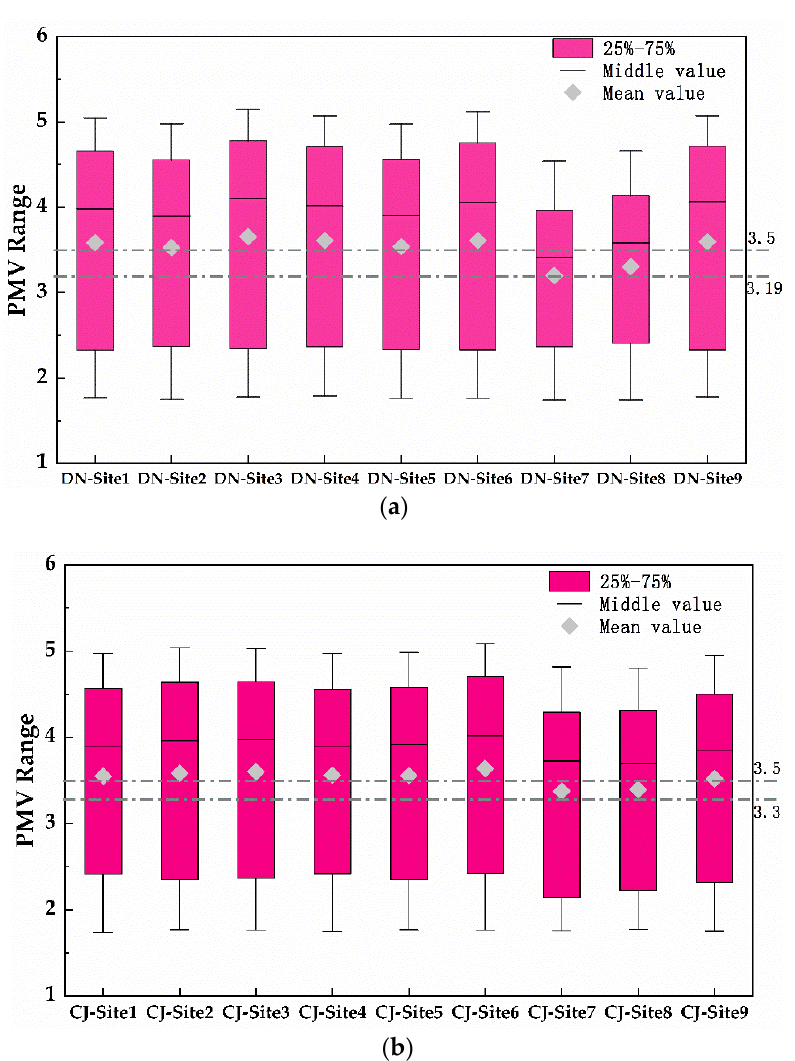
Figure 11. Box plot of mean PET at nine equal zones: ( a ) DN village, ( b ) CJ village.